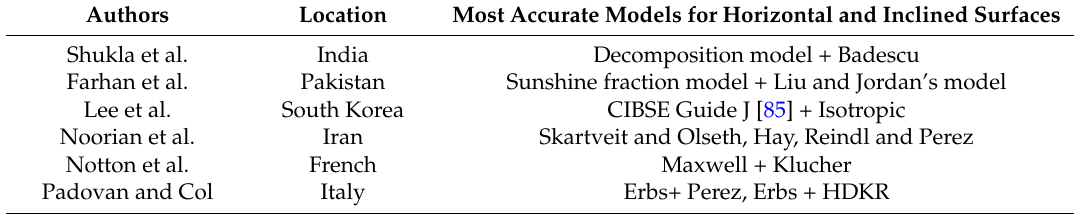
Table 8. Summary of studies on finding the most accurate diffuse models for horizontal and inclined